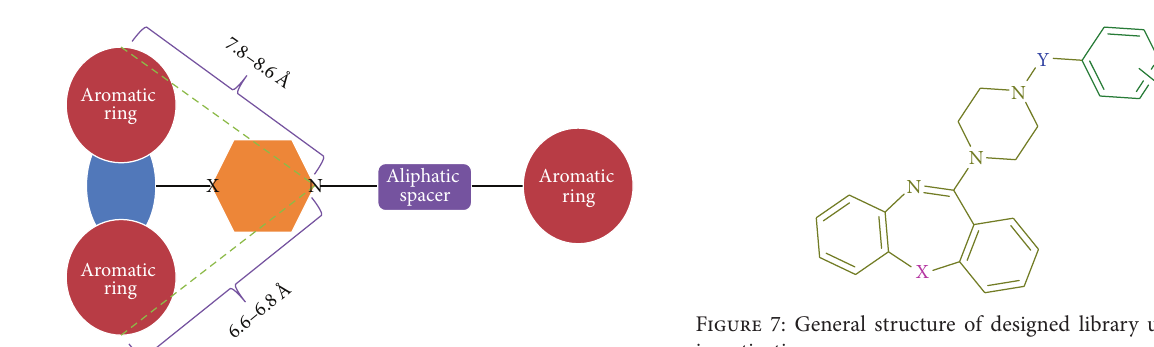
receptor with template 2RH1. 2A